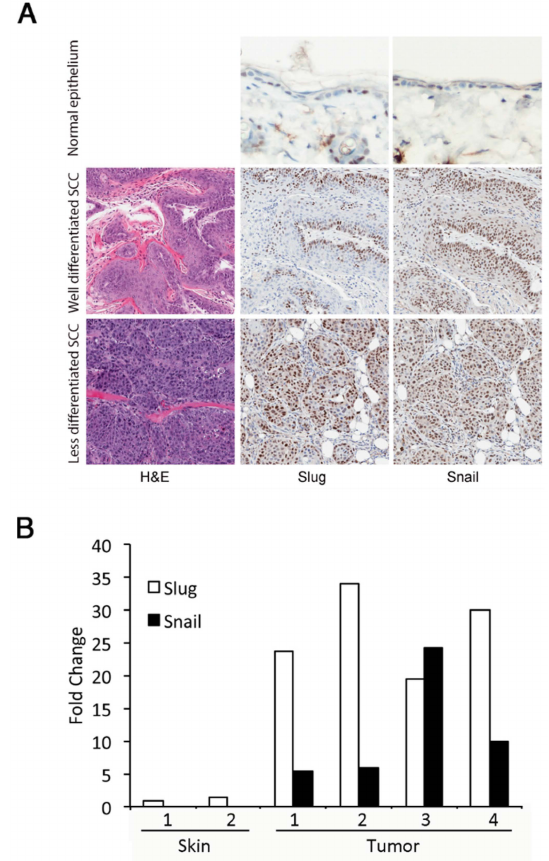
Figure 1. Slug and Snail are expressed at increased levels in 7,12-dimethylbenz[ α ]anthracene (DMBA)/12- O -tetradecanoylphorbol-13-acetate (TPA)-induced squamous cell carcinomas of the skin. ( A ) Immunohistochemistry for Slug and Snail was performed on normal untreated epidermis and on squamous cell carcinomas that arose in response to a standard DMBA/TPA two-stage carcinogenesis protocol. Representative normal epidermis and well-differentiated and more poorly differentiated tumors are shown. ( B ) mRNA from four of these squamous cell carcinomas was isolated, and the levels of Slug and Snail expression were determined by qRT-PCR. Expression in tumors was normalized to expression of Slug and Snail in the untreated epidermis (Skin Sample 1) of age- and strain-matched mice. Because Snail mRNA was undetectable in untreated epidermis, Snail mRNA levels were also normalized to Slug expression in untreated epidermis. The values obtained for Snail were multiplied by 1000 to allow them to be shown alongside values for Slug on this